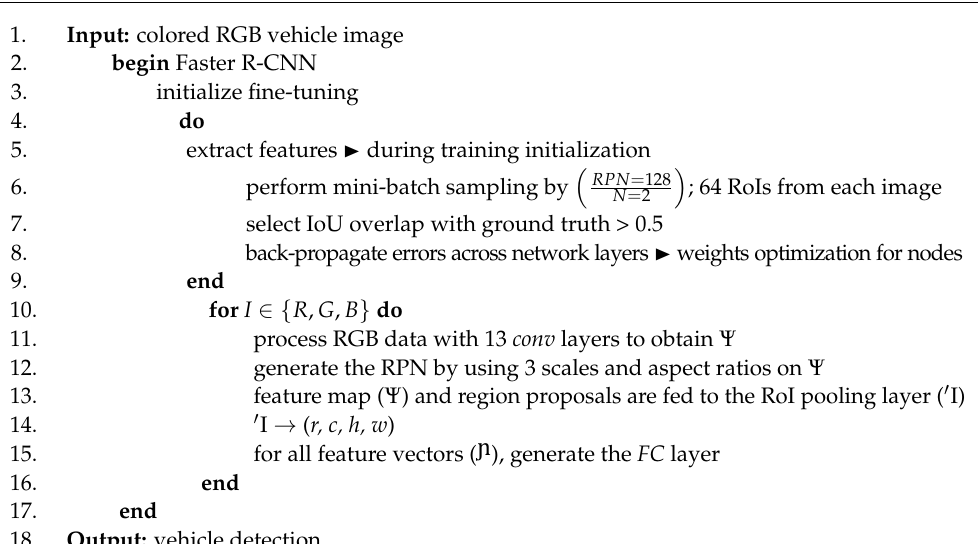
Algorithm 1: Pseudocode of the vehicle detection